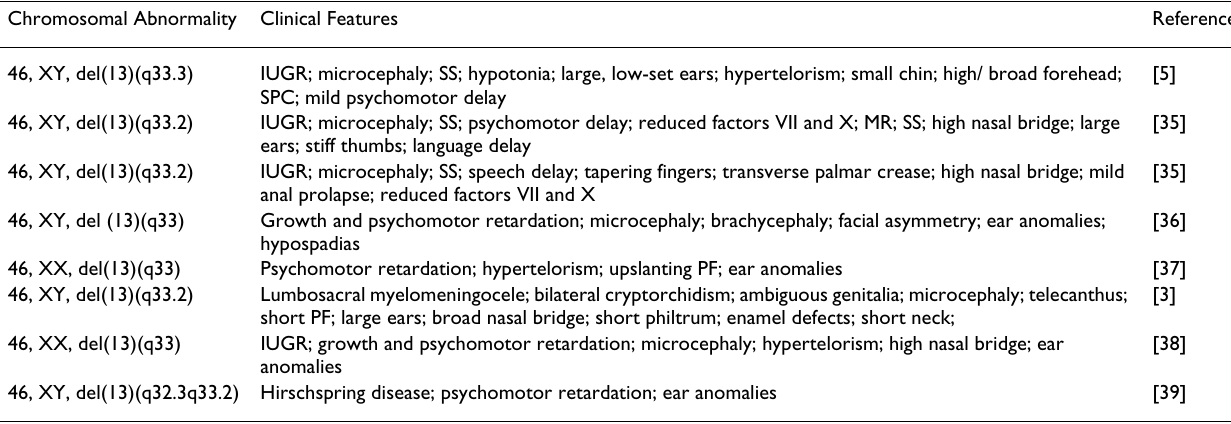
Table 1: Summary of cases with relatively isolated monosomy 13q33-qter. Chromosomal Abnormality Clinical